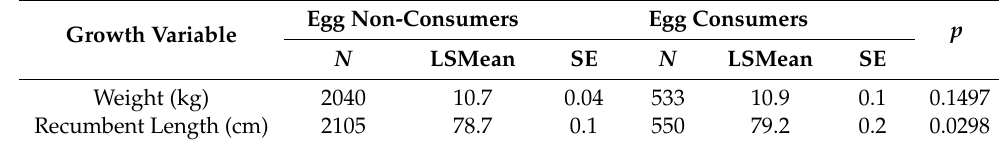
Table 5. Adjusted mean (SE) recumbent length for egg consumers vs. egg